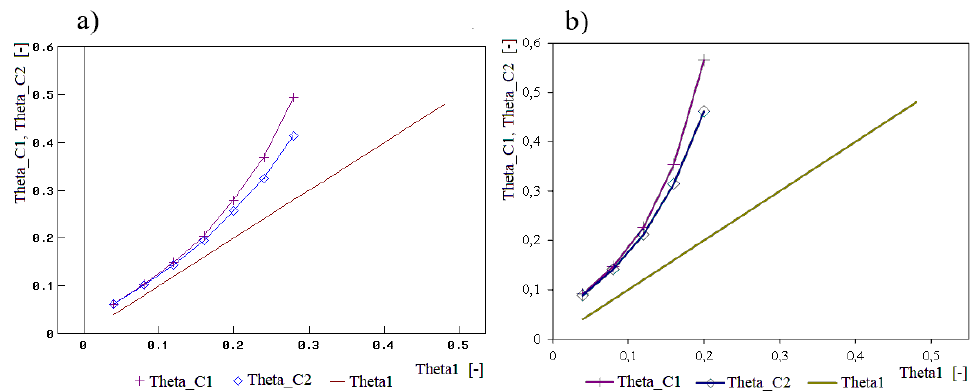
Figure 7: Values of diagnostic parameters ϑ C 1 (Theta_C1) and ϑ C 2 (Theta_C2) as functions of the dimensionless coeflcient of damping in the suspension system ϑ 1 (Theta1), obtained from an analysis of the factor of gain in the vertical force at the tire-exciter contact point (relative to the input force) close to the second natural frequency of the front “quarter car”: a) results for the linear model; b) results for the nonlinear model